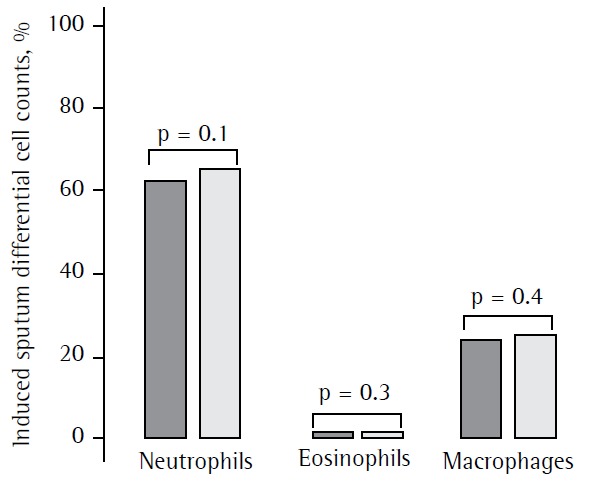
Median differential cell counts on the cytospin slides stained either with
May-Grünwald-Giemsa (dark gray bar) or Diff-Quik (light gray bar)